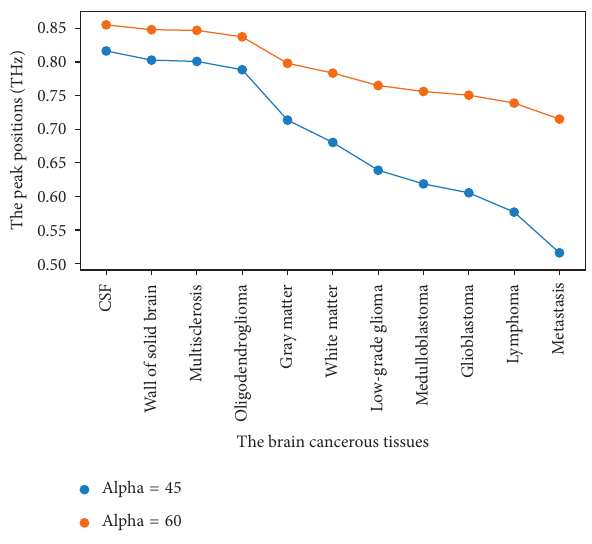
� 45 ° (a) and θ � 60 ° (b). int int